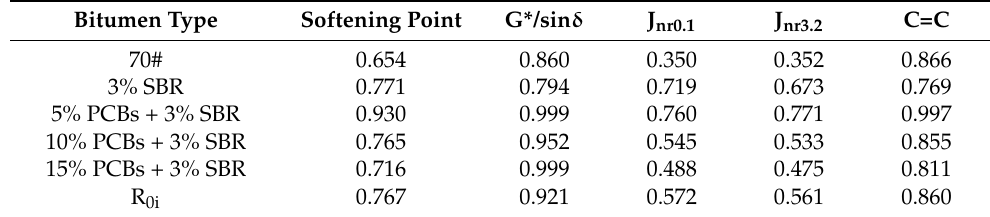
Table 10. The results of grey relational analysis on dynamic stability of bitumen and bituminous mixture. Bitumen Type Softening Point G*/sin δ J nr0.1 J nr3.2 C=C